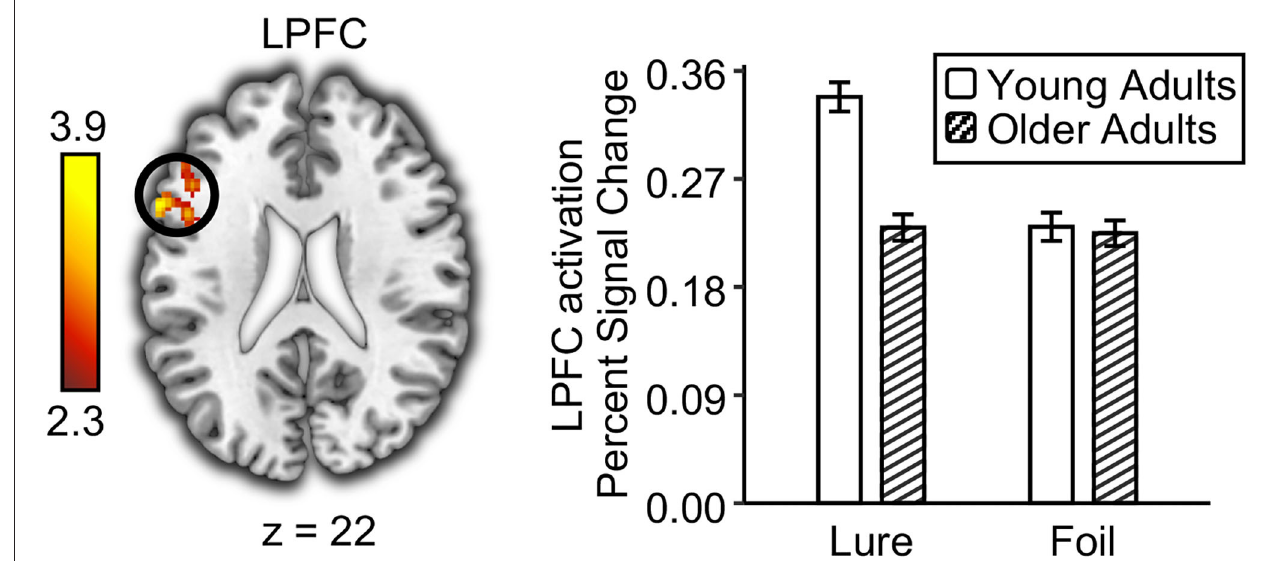
FIGURE 4 | Age deficits in prefrontal monitoring process at retrieval. The left lateral prefrontal cortex (LPFC) showed greater univariate activation to lures than to foils in young adults compared to older adults. The bar graph shows the univariate activation level in the left lateral prefrontal cortex for lures and foils in young and older adults. Error bar indicates standard errors of the